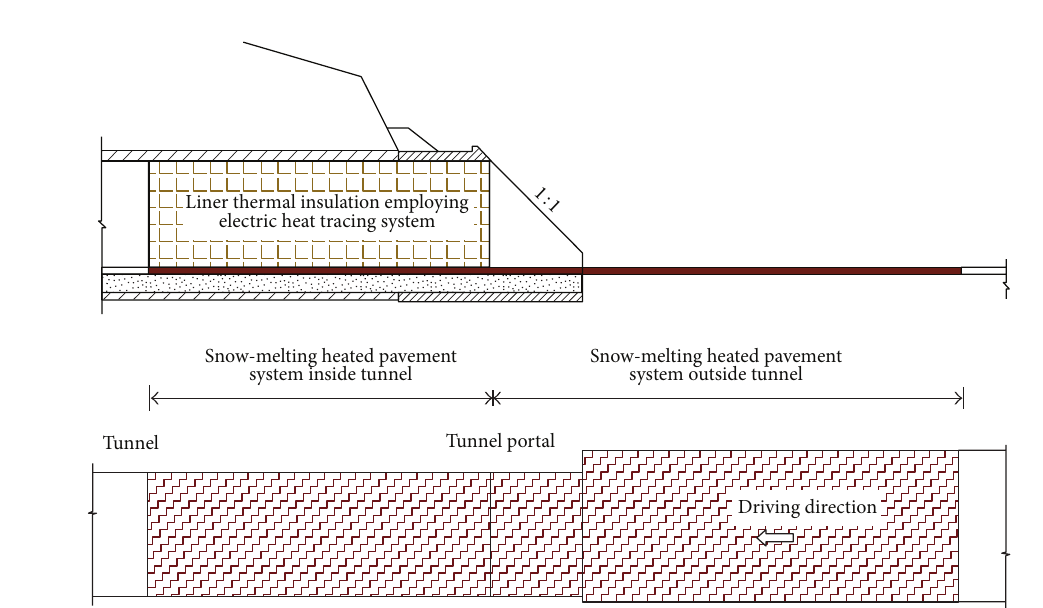
Figure 5: The snow-melting heated pavement